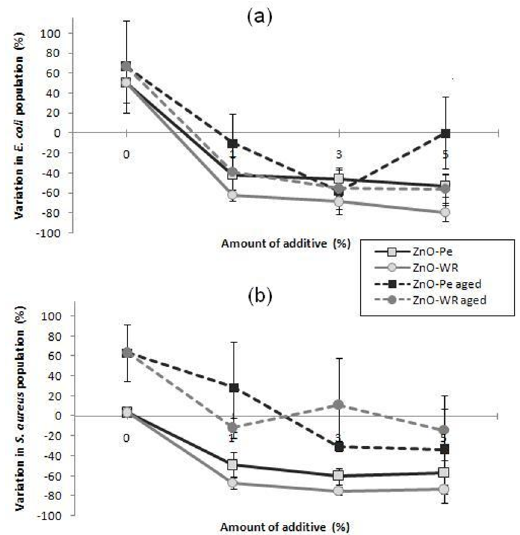
Figure 5. Variation in (a) E. coli and (b) S. aureus population in aged and unaged ZnO loaded TPE compounds. Error bars means ± SD of three